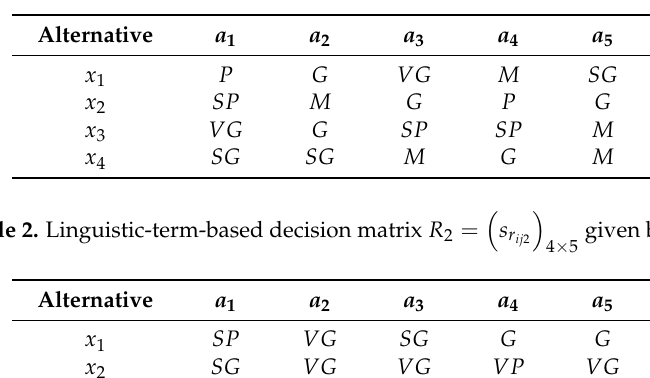
Table 1. Linguistic-term-based decision matrix R 1 =